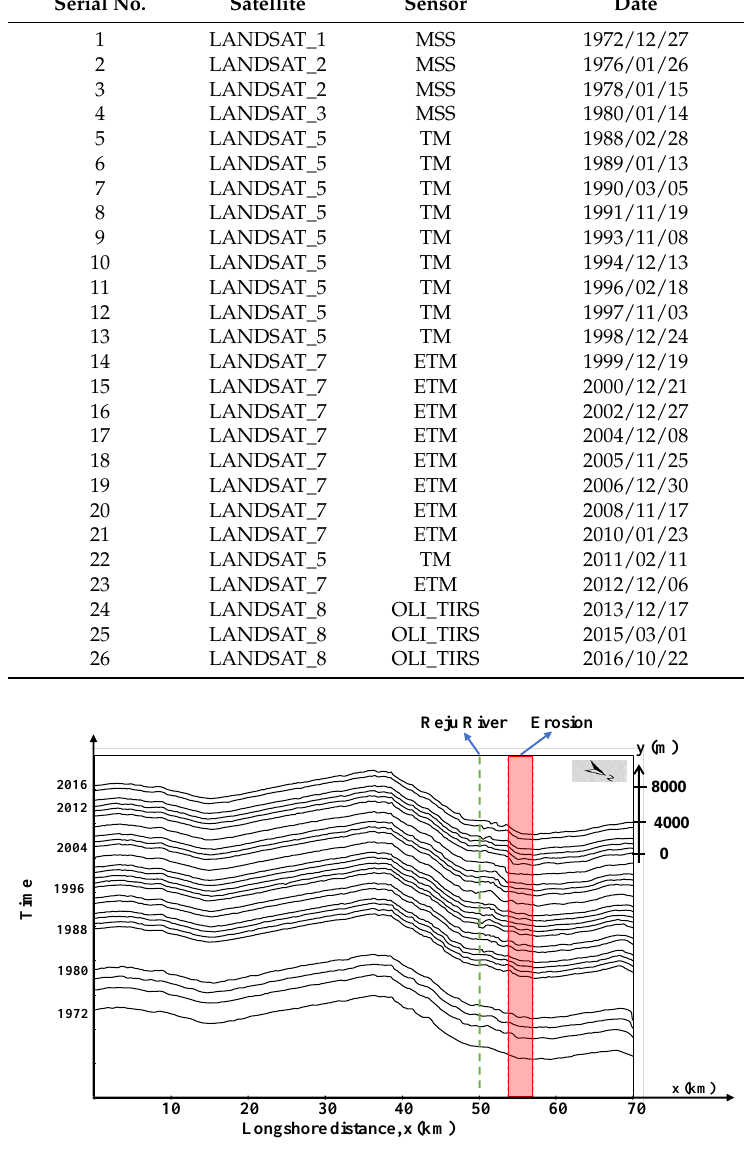
Figure 2. Extracted shorelines from Landsat images during 1972–2016.